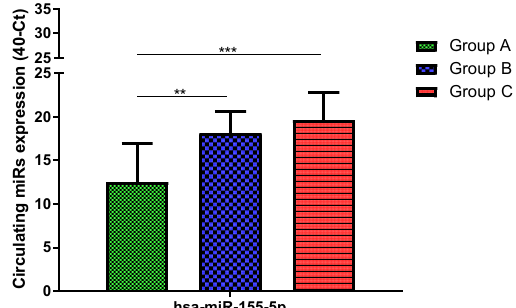
Figure 1. Serum levels of hsa-miR-155-5p in HNW (Group A), MANW (Group B) and HNAO (Group C). Results were shown as means ± SD. The statistical tests used in these analyses were one-way analysis of variance using Kruskal–Wallis test followed by Dunn’s Multiple Comparison Test. ** p < 0.01, *** p < 0.001.